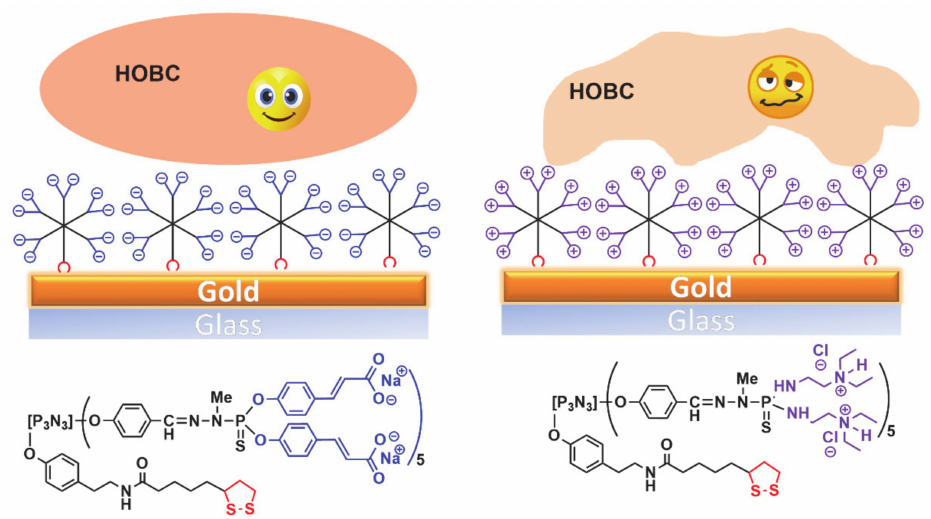
Figure 3. Dendrons functionalized with thioctic acid at the core for grafting to gold surfaces, and with positively or negatively charged terminal functions. The modified surfaces were used as supports for cultures of human osteoblast cells